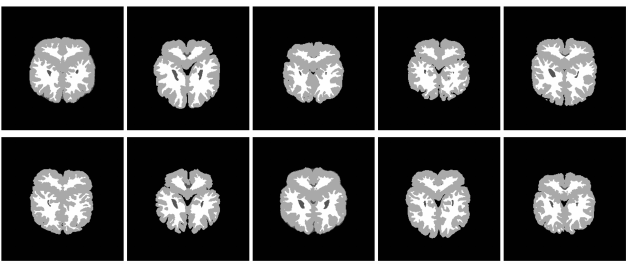
Figure 12. Ideal manual segmentation